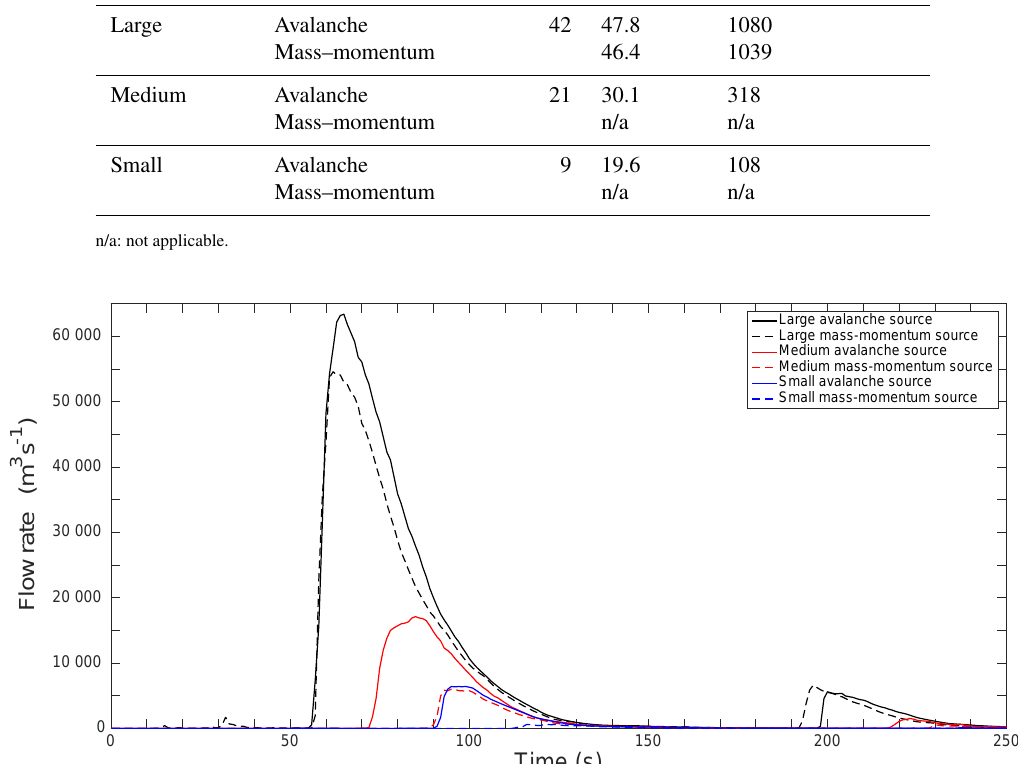
Figure 7. Overtopping wave discharge hydrographs for the three avalanche events and two types of boundary conditions with the lake at the baseline